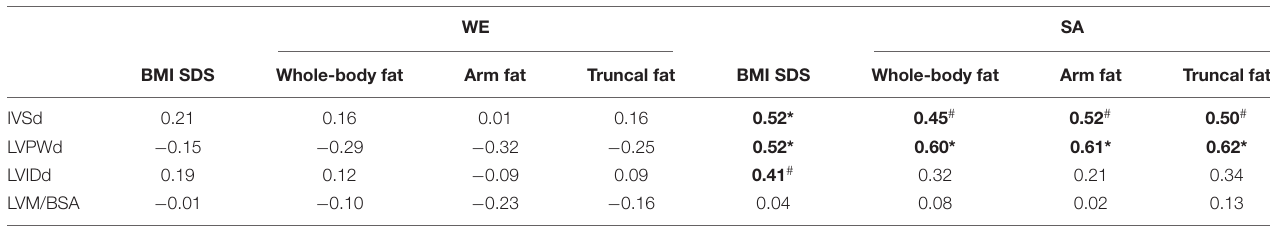
TABLE 4 | Correlations (Spearman) between child’s body composition and cardiac measures by ethnic group (WE n = 28 and SA n = 27).